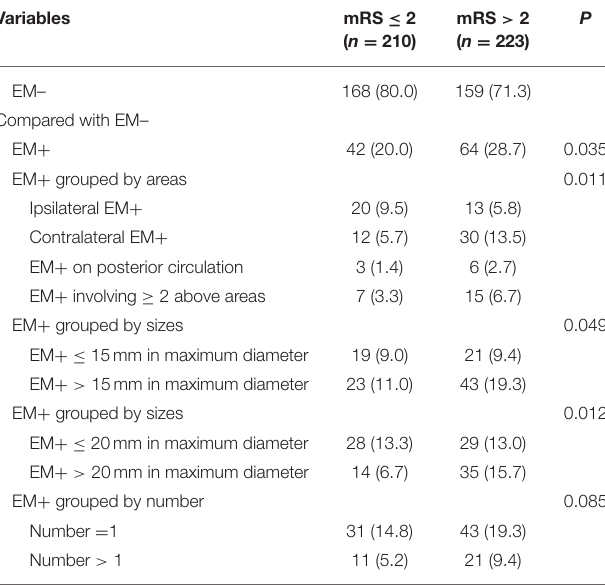
TABLE 2 | Univariate analysis between a pre-existing encephalomalacia (EM) and a stroke outcome at 90 days.